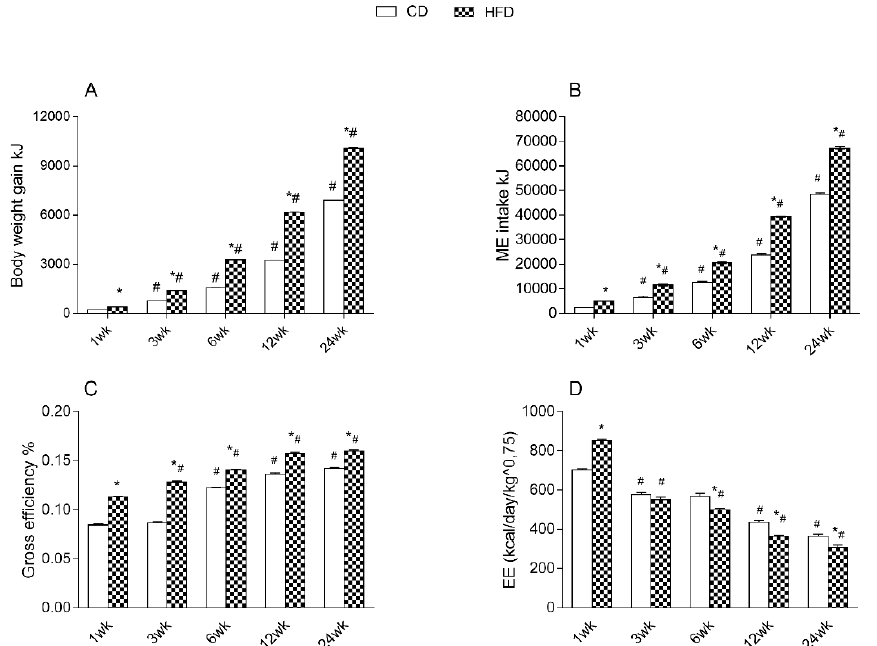
Figure 2. Effects of high-fat diet and aging on energy balance. All the parameters were measured throughout the experimental period (1–24 weeks): ( A ) body weight gain; ( B ) metabolizable energy (ME) intake; ( C ) gross efficiency; ( D ) energy expenditure (EE) are shown. Data are indicated as means ± SEM from n = 6 animals/group. # Significantly different compared to previous time point, p < 0.05; * significantly different compared to CD group, p < 0.05.